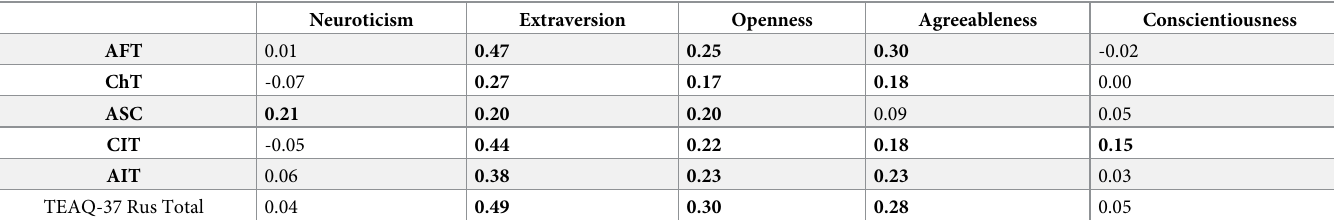
Table 6. Correlations of the TEAQ-37 Rus subscales with the Big Five personality factors ( r values).